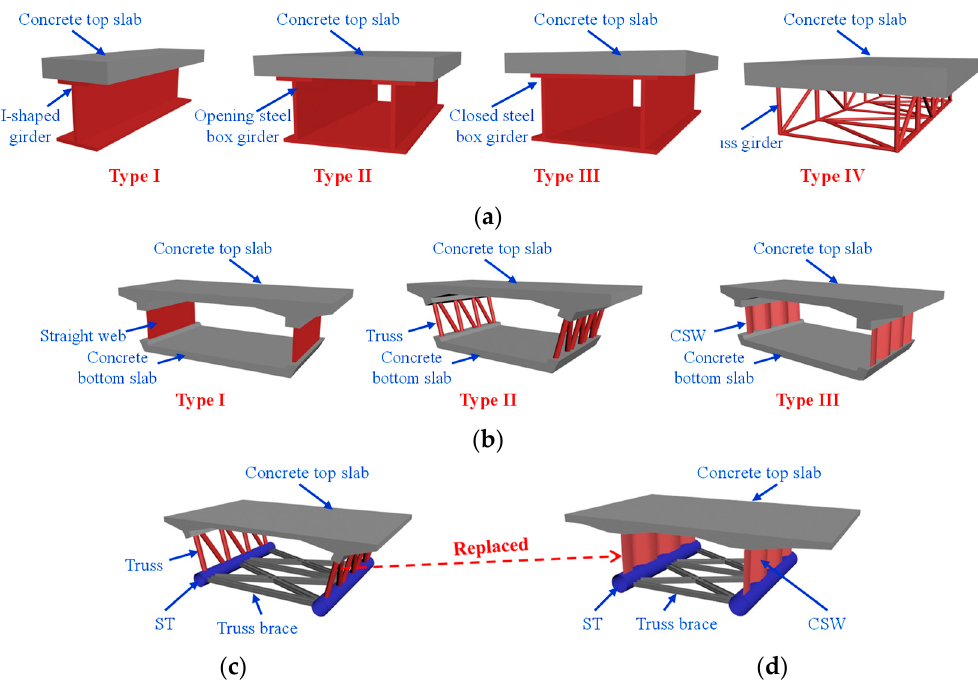
Figure 1. Types of composite girders: ( a ) steel girder-concrete slab girders; ( b ) steel web-PC girders; ( c ) truss girders; and ( d ) composite girders with CSW and ST truss.